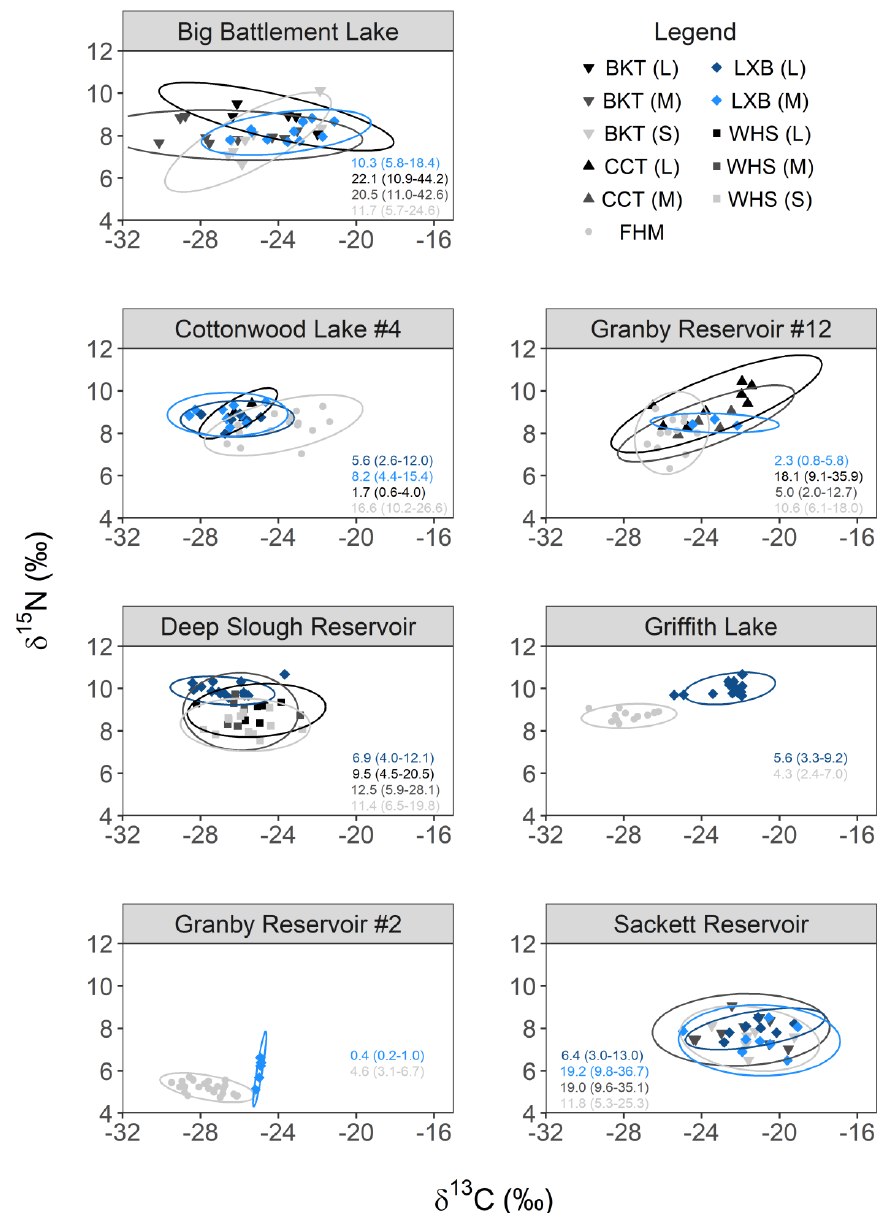
Figure 2. Bi − plot of δ 13 C and δ 15 N values (points) for each individual of each species and size-group of fish sampled from each study system. Lines represent corresponding 95% prediction ellipses used to compute trophic niche space (‰ 2 ; values on each panel) and trophic niche overlap among species and size-groups within the same system. In some instances, size-groups of fish needed to be combined to meet minimum sample size requirements for computing trophic niche overlap. Medium (M; 150 − 249 mm TL; n = 10) and large (L; ≥ 250 mm TL; n = 1) tiger trout (LXB) in Big Battlement Lake were combined, but coded as medium-sized fish as these were the majority. Medium ( n = 2) and large ( n = 2) cutthroat trout (CCT) were combined in Cottonwood Lake #4, but since medium fish were close in size to large fish, they were all coded as large. Medium ( n = 2) and large ( n = 12) tiger trout in Deep Slough Reservoir were combined and coded as large-sized fish as these were the majority. Medium ( n = 3) and large ( n = 2) tiger trout in Granby Reservoir #2 were combined, but coded as medium-sized fish as these were the majority. Medium ( n = 2) and large ( n = 1) tiger trout in Granby Reservoir #12 were combined, but coded as medium-sized fish as these were the majority. Lastly, small ( n = 1) and medium ( n = 6) tiger trout were combined in Sackett Reservoir, but coded as medium-sized fish as these were the